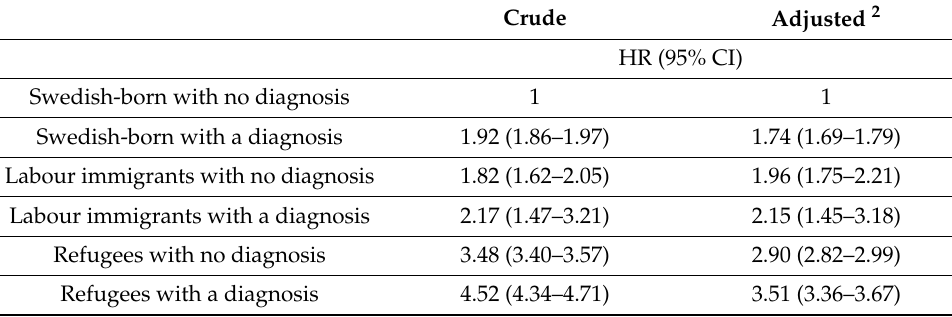
Table 4. Hazard ratios (HRs) with 95% confidence intervals (CIs) for the risk of not reaching self- sufficiency 10 years after immigration among labour immigrants and refugees with or without a diagnosis from hospitalisation or specialised outpatient care 1 compared to Swedish-born without a diagnosis.